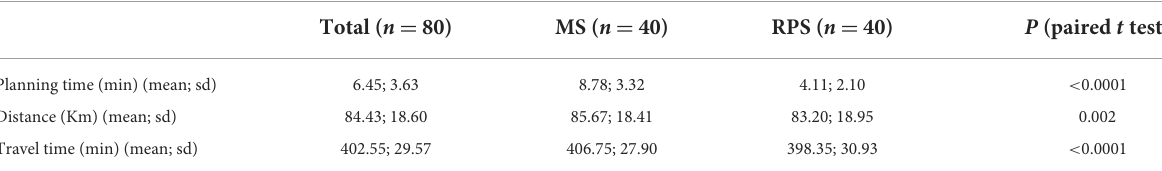
TABLE 4 Comparing the planning method attending to difficulty. Plan difficulty: Easy. comparing planning